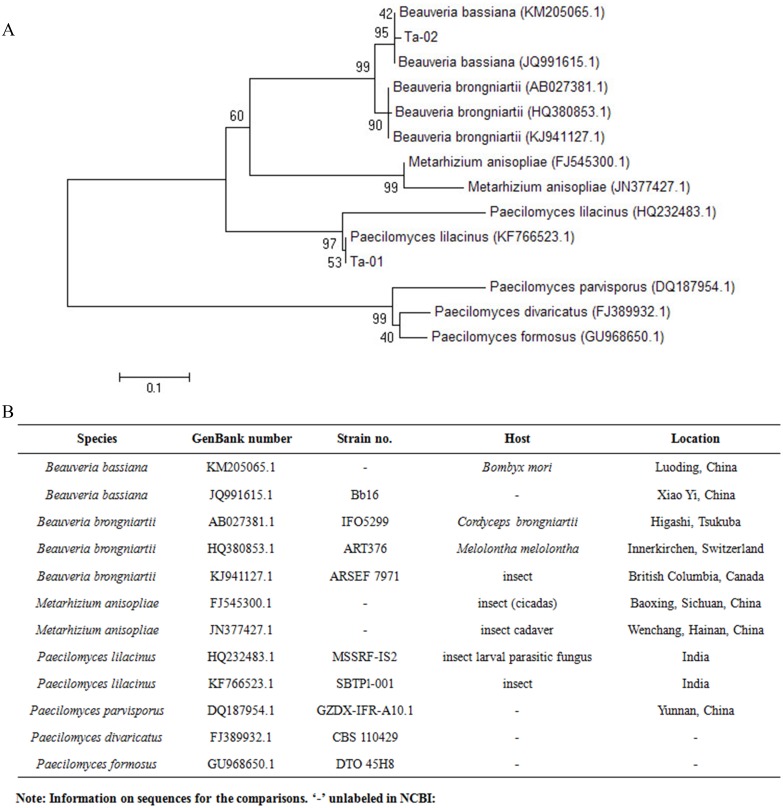
Phylogenetic tree based on the 28S rDNA sequence of strains Ta-01 and Ta-02.MEGA 4 was used to construct the phylogenetic tree. Bootstrap analyses from 1,000 replications are shown by each branch.